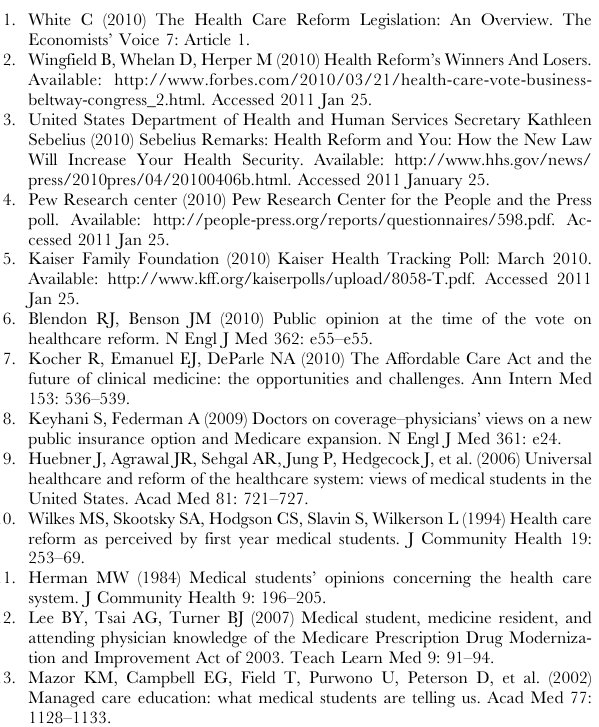
Table S7 1Participants were given a choice of five pre-formed